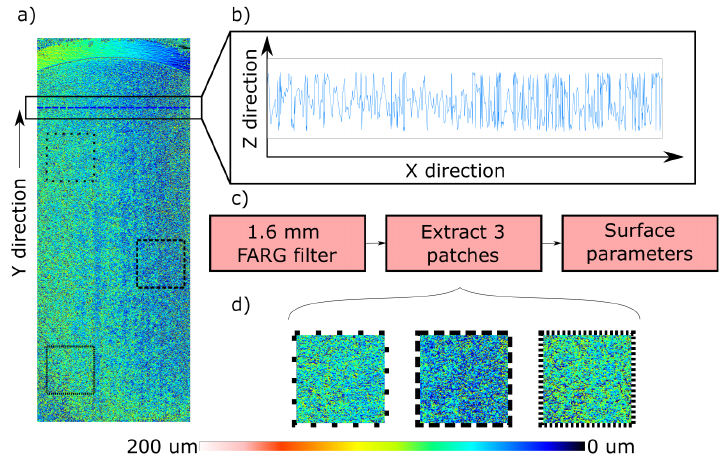
Figure 4. Example of surface map ( a ) with extracted profile ( b ), analysis algorithm ( c ) and extracted patches ( d ).